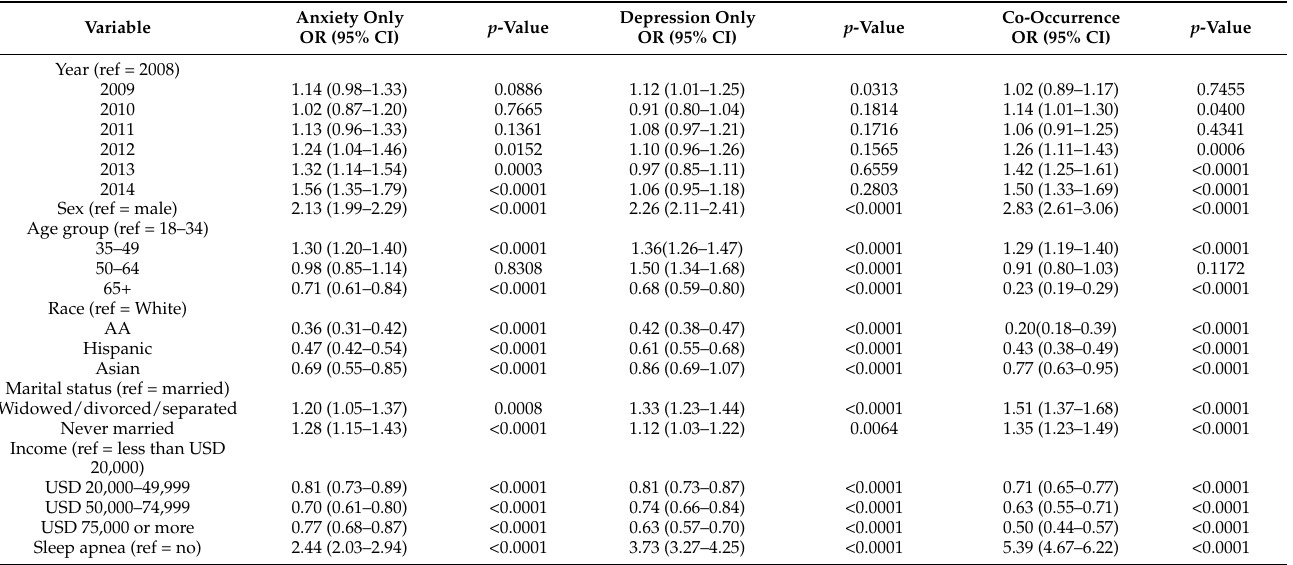
Table 4. Multinomial logistic regression analyses of potential factors with anxiety only, depression only, and their